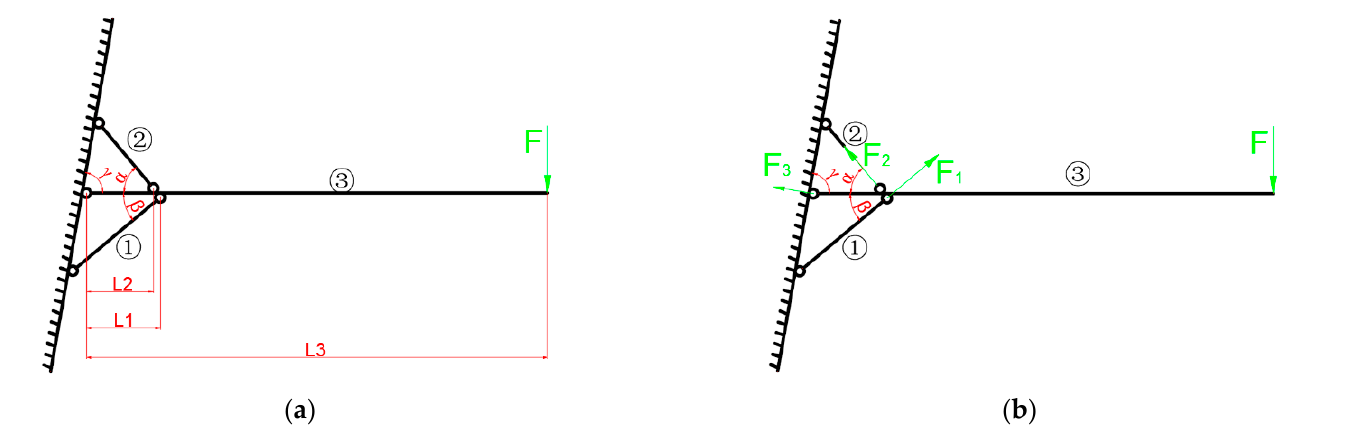
Figure 8. ( a ) Simplified mechanical model and ( b ) Force analysis of bar No. 3 in the T-joint.